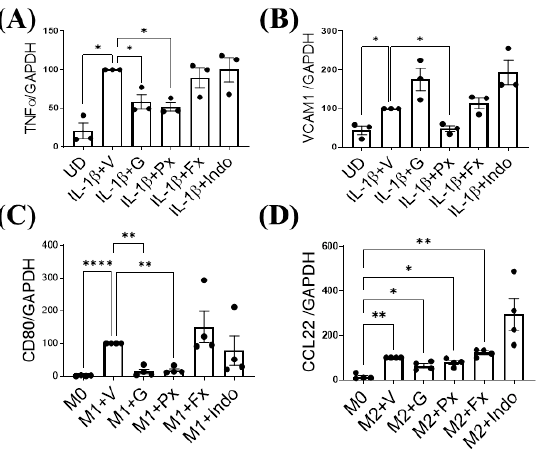
Figure 7. G βγ -GRK2 inhibition ameliorates synoviocyte inflammation and M1 macrophage differ- entiation in human cells. Changes in mRNA gene expression of synoviocyte inflammatory markers ( A ) TNF α and ( B ) VCAM1 in human synoviocytes (FLS-differentiated SW982 cells and undifferen- tiated cells (UD)). IL-1 β -stimulated SW982 cells were treated with vehicle (IL-1 β + V) gallein (1 β + G), paroxetine (1 β + Px), fluoxetine (1 β + Fx), and indomethacin (1 β + Indo). Changes in mRNA gene expression of macrophage phenotype markers ( C ) CD80 and ( D ) CCL22 in human macrophage cells (M1- and M2-differentiated THP1 cells). Macrophage cells differentiated into M1 or M2 macrophage phenotypes and resting macrophages (M0) were treated with vehicle (M1/M2 + V), gallein (M1/M2 + G), paroxetine (M1/M2 + Px), fluoxetine (M1/M2 + Fx), and indomethacin (M1/M2 + Indo). RT- qPCR from n = 3 experimental replicates. Data are normalized to expression of GAPDH. * p < 0.05 vs. IL-1 β + V group; ** p < 0.01 and **** p < 0.0001 vs. M1 + V group; * p < 0.05 and ** p < 0.01 vs. M0 + V group using one-way ANOVA. Values are expressed as means ± SEM. 3. Discussion In the current study, we investigated the therapeutic efficacy of G βγ -GRK2 inhibition in attenuating inflammation and preventing OA development when administered at the time of injury in DMM mice. We recently reported that G βγ -GRK2 inhibition attenuates cartilage degeneration and synovitis in ongoing PTOA when administered from week 8 to week 12 following DMM [16]. Here, we found that G βγ -GRK2 inhibition, by gallein and paroxetine treatment at the time of injury, exerted a strong anti-inflammatory effect extending from the early stages to the late stages of DMM. This early intervention protects the chondrocytes from apoptosis in the early phase of OA, thereby preserving the articular cartilage and ameliorating OA development. Osteoarthritis is the most common joint disease, leading to severely affected quality of life and mobility due to degenerative joint changes, including cartilage degeneration, subchondral bone remodeling, osteophytes formation, synovitis, the degeneration of lig- aments and menisci of the knee, and hypertrophy of the joint capsule [1]. A large body of evidence suggests that inflammation of the synovium (synovitis) cor- relates with the pathogenesis and development of OA [4,23,24]. We hypothesized that early G βγ -GRK2 inhibition can impart protection to prevent or decelerate OA develop- ment in the early inflammatory phase following DMM due to their outlined anti-inflam- matory effects [10,16]. Therefore, we compared the chondroprotective and chondroregen- erative effects of gallein and paroxetine treatment initiated in the early-stages (at the time of injury) to our recently reported results with delayed treatment initiation (8 weeks fol- lowing DMM) [16]. The early treatment was more chondroprotective and matrix-regener- ative, where the area of uncalcified cartilage was maintained at levels close to those of sham mice, indicating attenuated OA development. To determine the possible mechanism behind this effect, we investigated changes in chondrocyte apoptosis one week after DMM. In early OA, inflammatory synoviocytes and macrophages secrete cytokines that lead to cartilage damage and OA development [1,8], and apoptosis plays a major role in